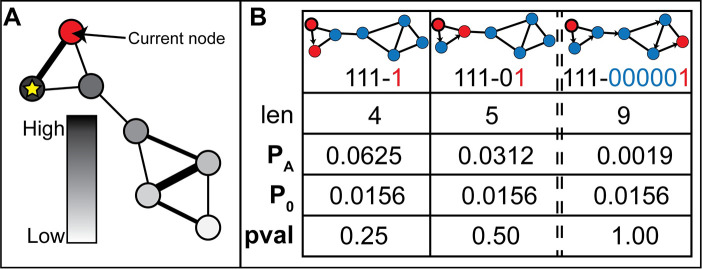
Diffusion of probability from a starting node and a diffusion-based encoding algorithm.(A) Node color denotes a gradient of probability inherited from the diffusion of probability from the current node (in red). The node with the yellow star denotes the node which inherited the highest probability. (B) A set is assigned higher probability (PA) if it is highly connected and assigned lower probability if it is sparsely connected in the graph. The arrows point to the node the diffusion-based node ranking algorithm ranked highest, based on diffusion of probability from the previous encoded node. While the p-value of the most connected node set of size 2 for the graph illustrated here is 0.25, with larger graphs and larger subset sizes, the potential for further compression increases, and thus, more significant p-values are possible.